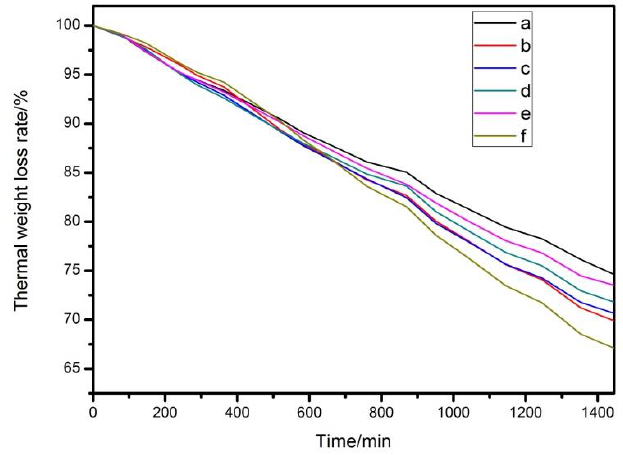
Figure 10. Thermal weight loss rate of ( a ) PVC + commercial LDHs + ZnSt 2 , and composite PVC + experimentally prepared LDHs + ZnSt 2 + ( b ) 0, ( c ) 0.1, ( d ) 0.2, ( e ) 0.3 and ( f ) 0.4 phr Zinc acetylacetonate.